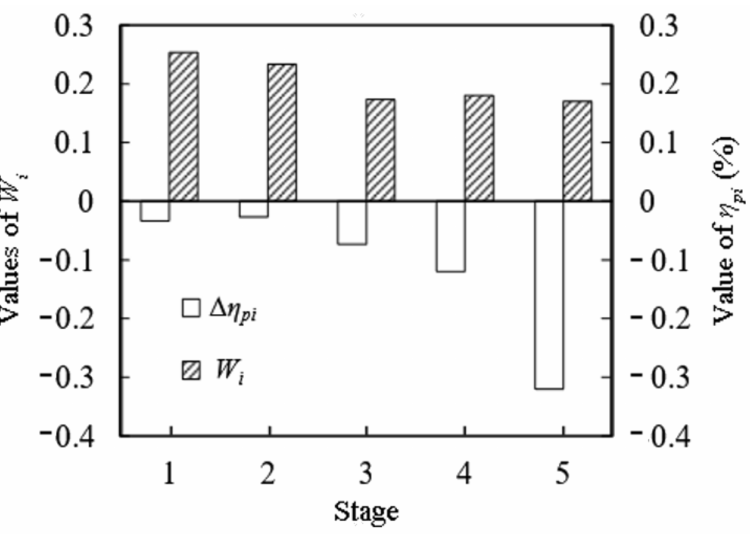
Figure 9. Histogram of weight variable value and efficiency decline value of each compressor